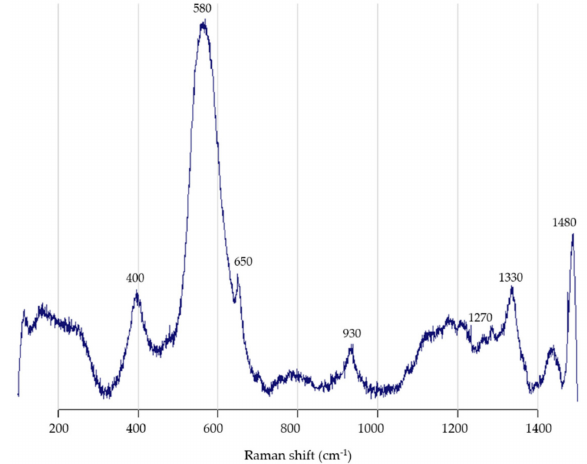
Figure 5. Representative Raman spectrum obtained on wood